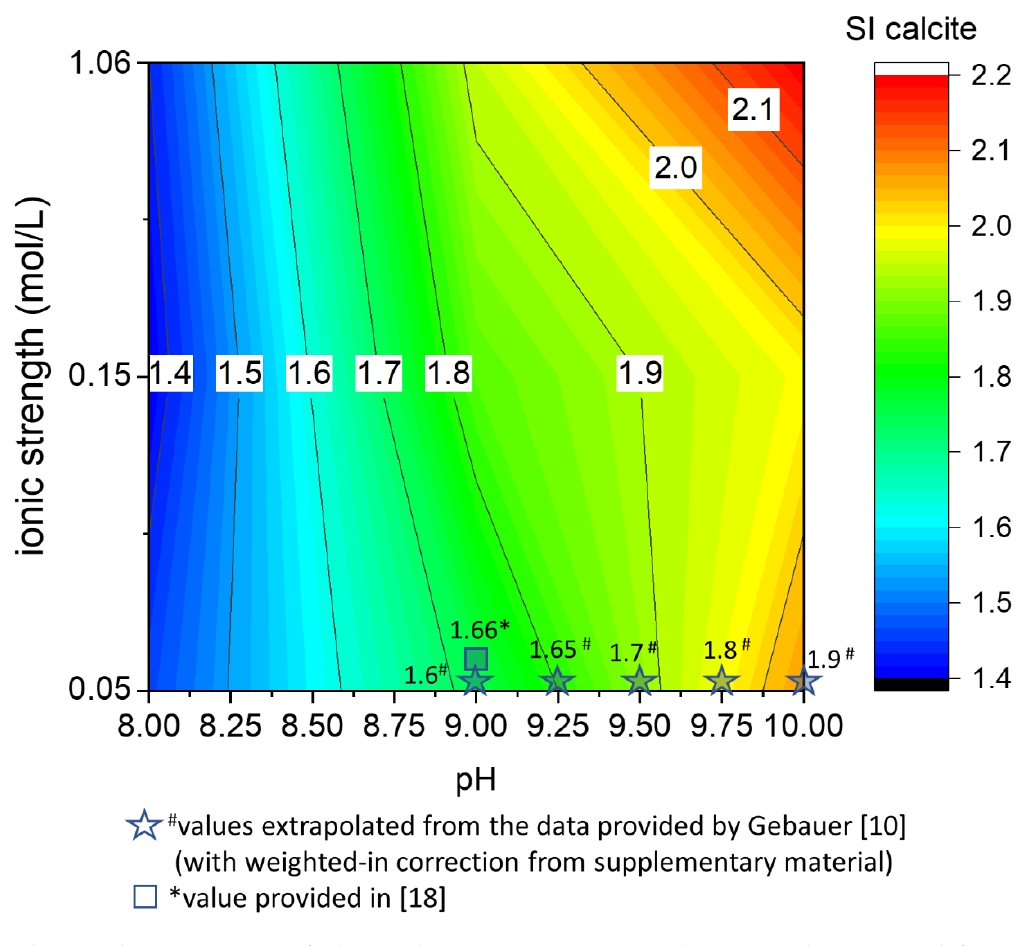
Figure 5. The critical supersaturation of calcite in the pure system is presented as a pH and ionic strength function. A color plot is a suitable representation for the matrix of data acquired with the precipitation experiments performed according to Table 1. To highlight the agreement between the saturation indexes of calcite reported in this work and previous studies, the values calculated from the literature are also plotted together with the experimental data.